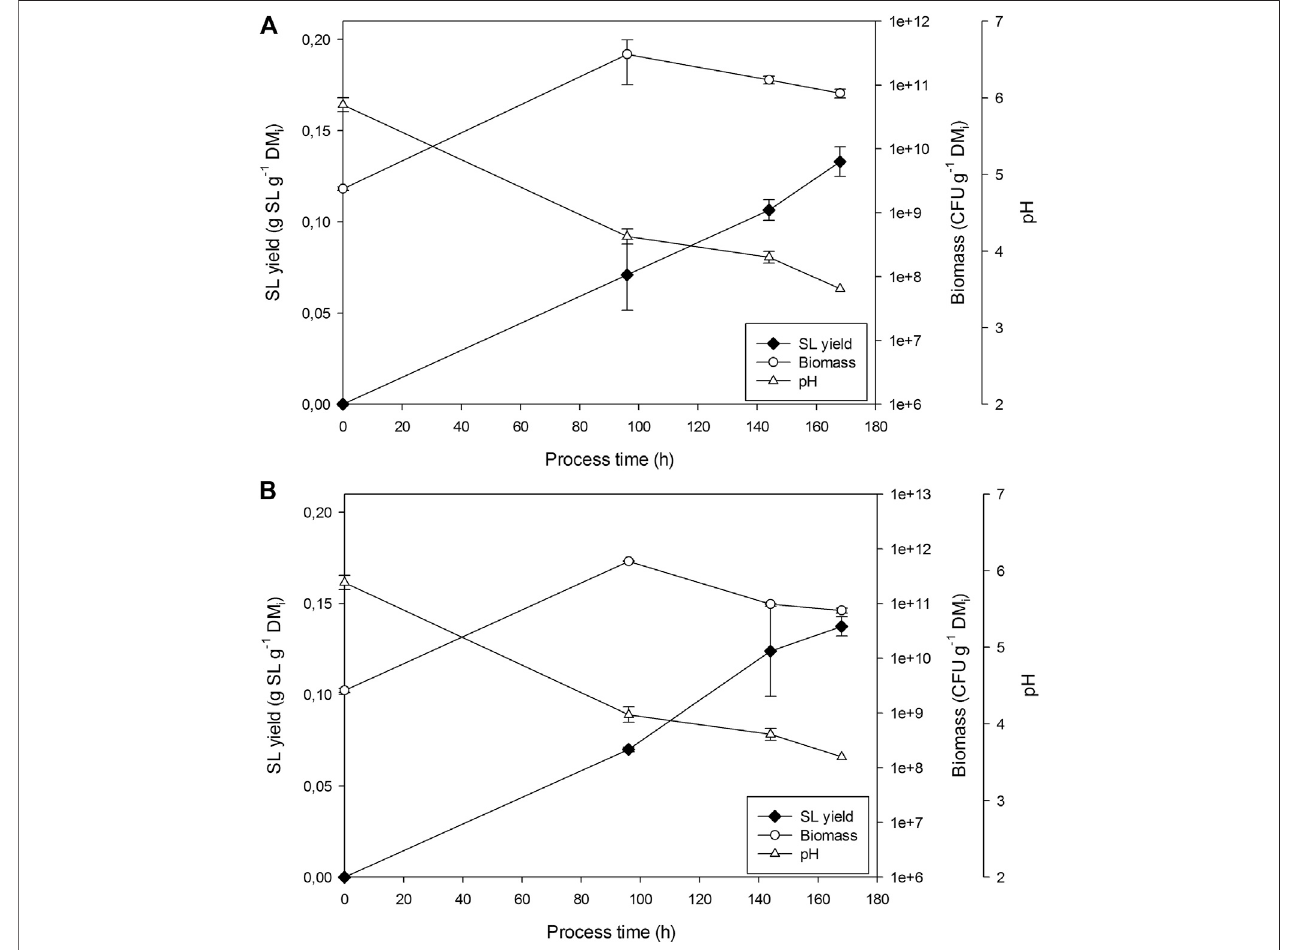
FIGURE 3 | Sophorolipids, pH and CFU evolution in fermentations in R100 for (A) replicate 1 and (B) replicate 2.